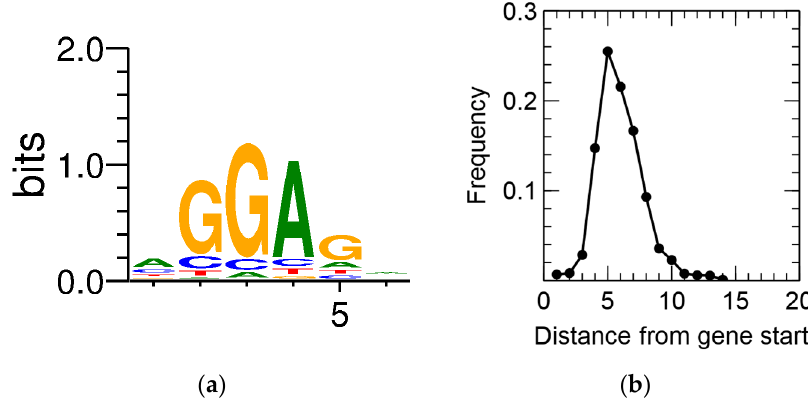
Figure 2. Ribosome-binding site sequence motif ( a ) and spacer length distribution ( b ) of C. metallidurans CH34.